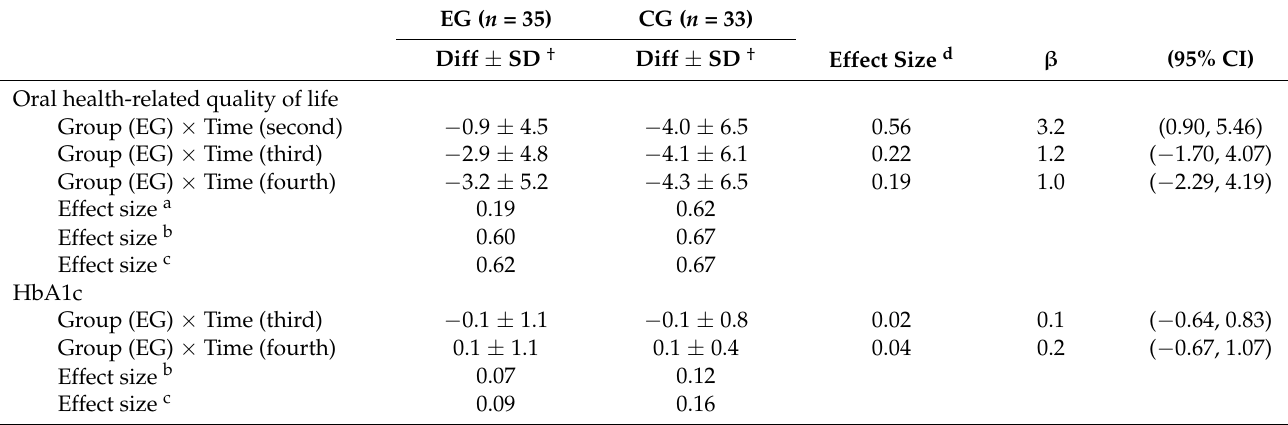
Table 4. Effect of changes in oral health-related quality of life and HbA1c at different stages (at baseline and at 1-month, 3-month and 6-month follow-up) by group among patients with